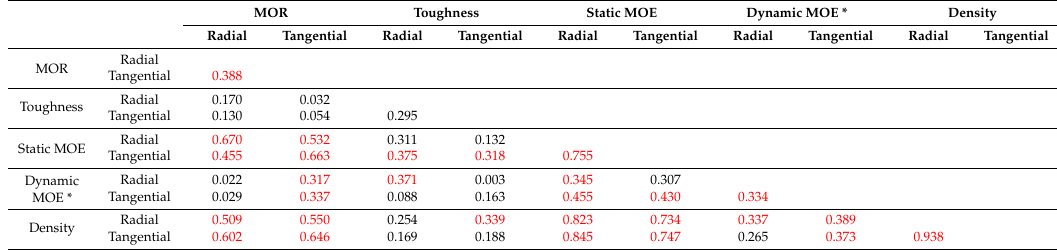
Table A10. Values of Correlation Coe ffi cients Between Given Quantities for Ash Wood.